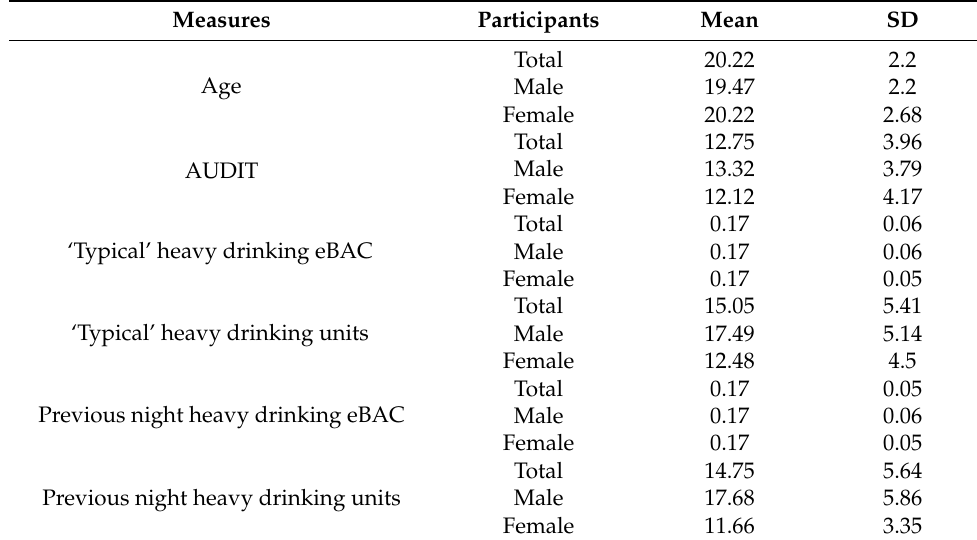
Table 1. Demographic characteristics of the sample and descriptive statistics regarding their alco- hol consumption.